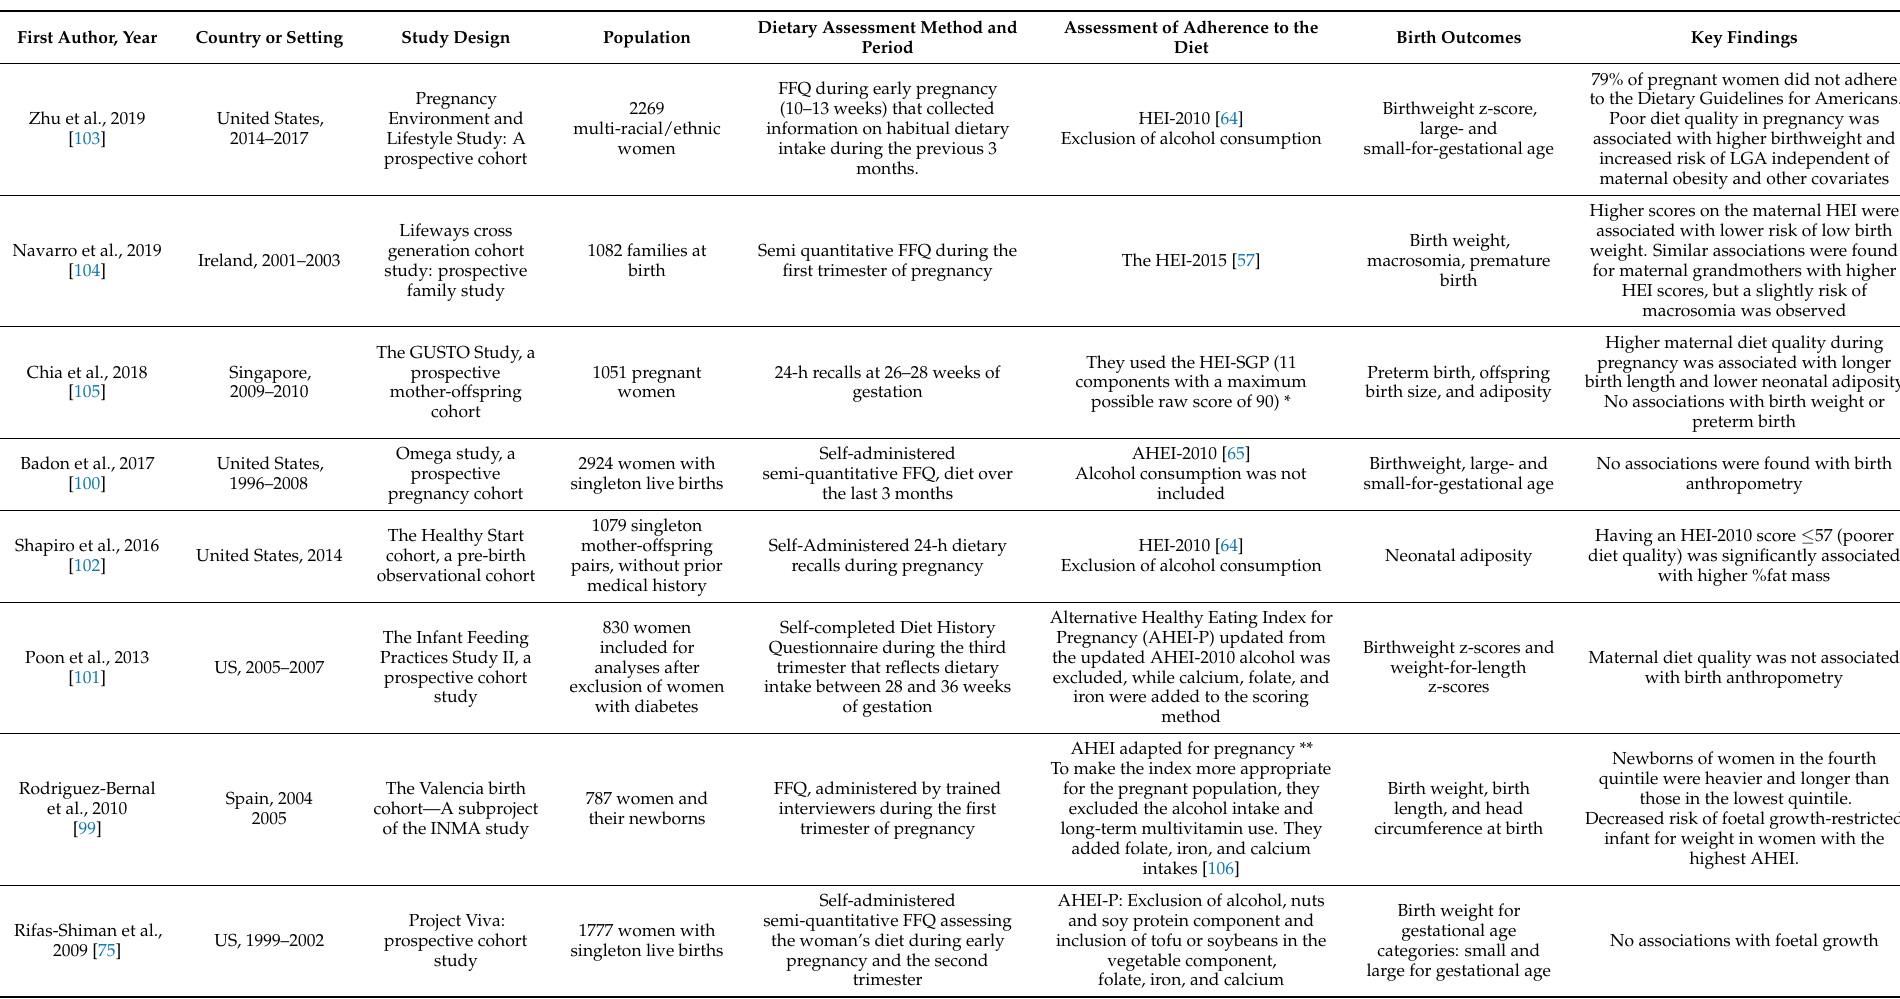
Table 4. Individual studies on the associations between maternal dietary quality determined by the Healthy Eating Index and birth